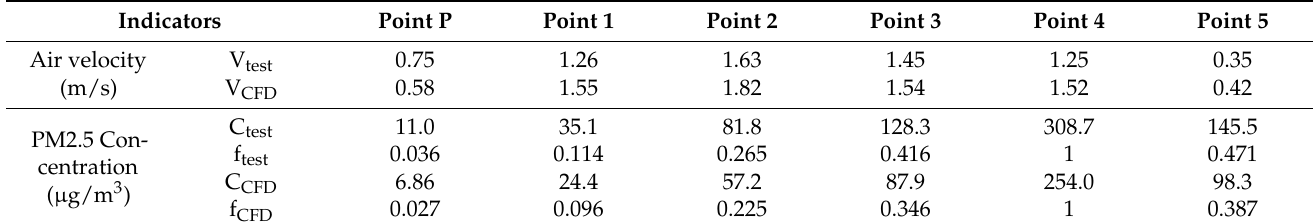
Table 5. Measured values and simulation results of each measurement point.